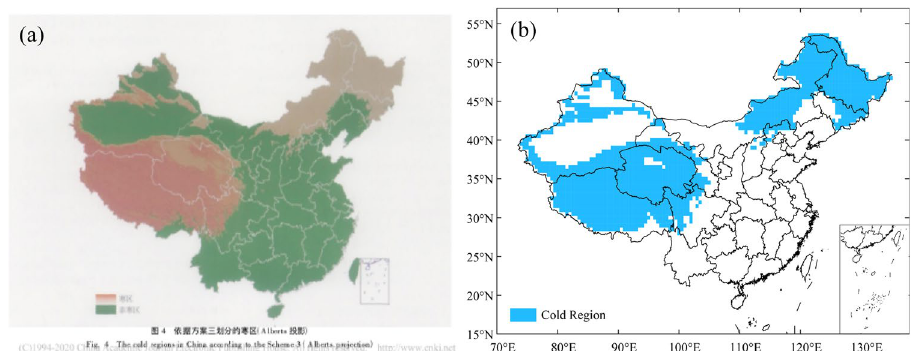
Figure 11. Comparison of spatial analysis results of the cold regions in China. ( a ) Research results of Chen (2005); ( b ) Analysis results of this